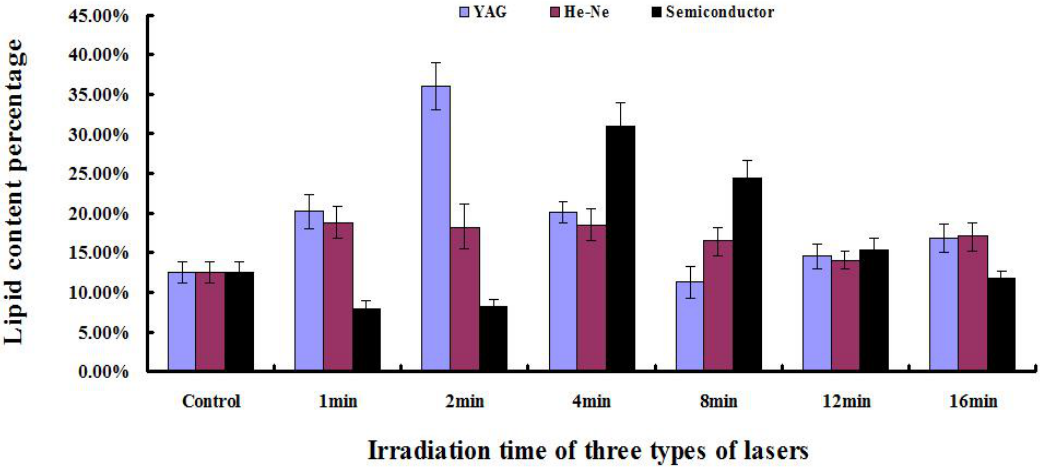
Figure 8. Total microalgal lipid content after irradiated for different time by three lasers.